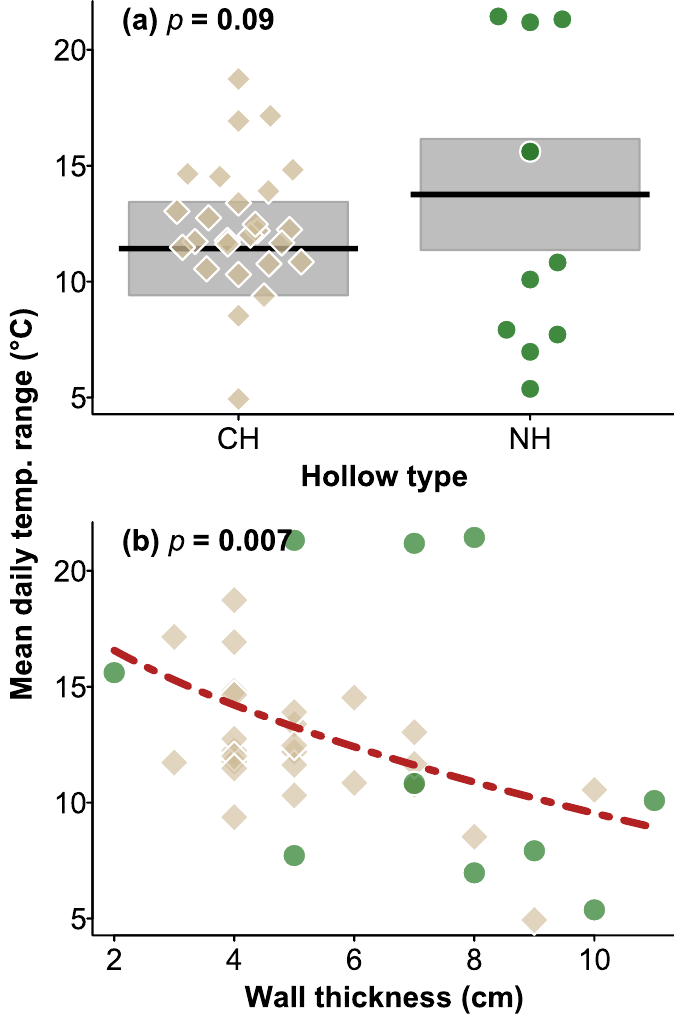
Figure 2. Plot of daily mean temperature range for ( a ) CHs and natural hollows and the relationship with wall thickness. In ( a ) shaded area are the 95% CI of the mean (black lines), the broken red line in ( b ) shows the relationship between hollow temperature range and hollow wall thickness, averaged across the categorical factors in the analysis. Brown squares and green circles in ( b ) indicate CHs and natural hollows, respectively, as shown in ( a ), indicating mean values for hollows in the 2018–2019 summer. p values for the effect of hollow type ( a ) and wall thickness ( b ) are shown at the top of the plots.